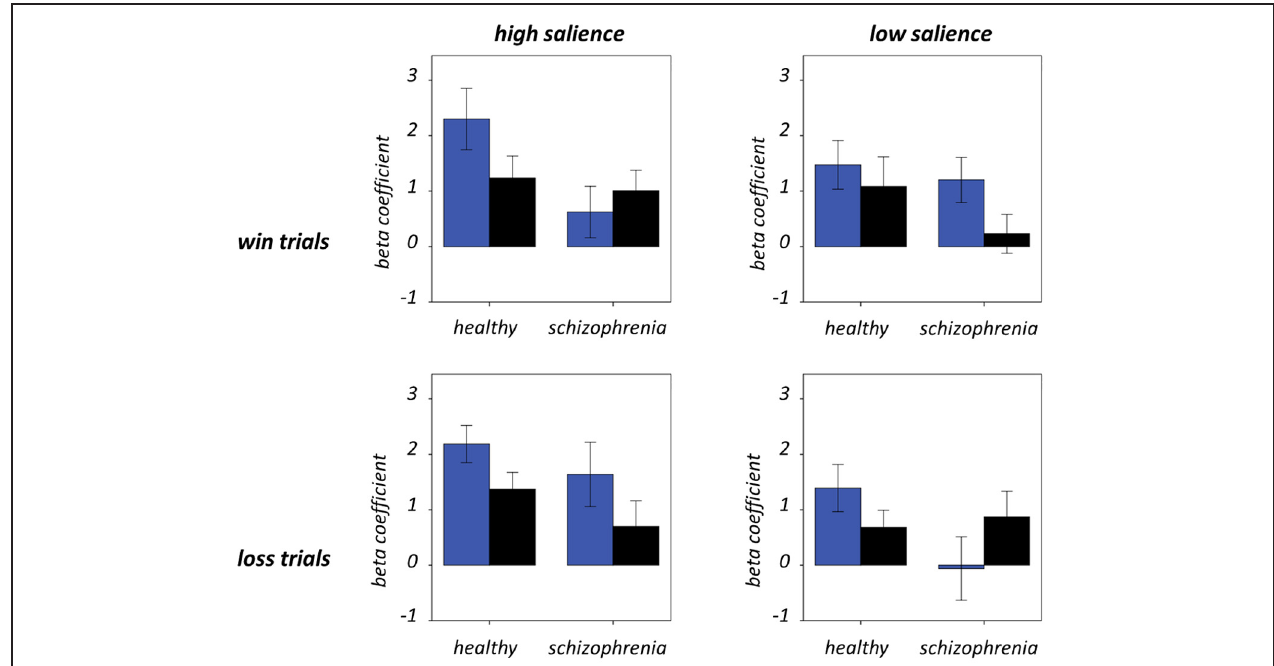
FIGURE 7 | Frontoinsular cortex component activity at trial outcome. Condition-specific beta coefficients are shown, with blue and black bars denoting hit and miss trials, respectively. Error bars denote standard error of the mean.